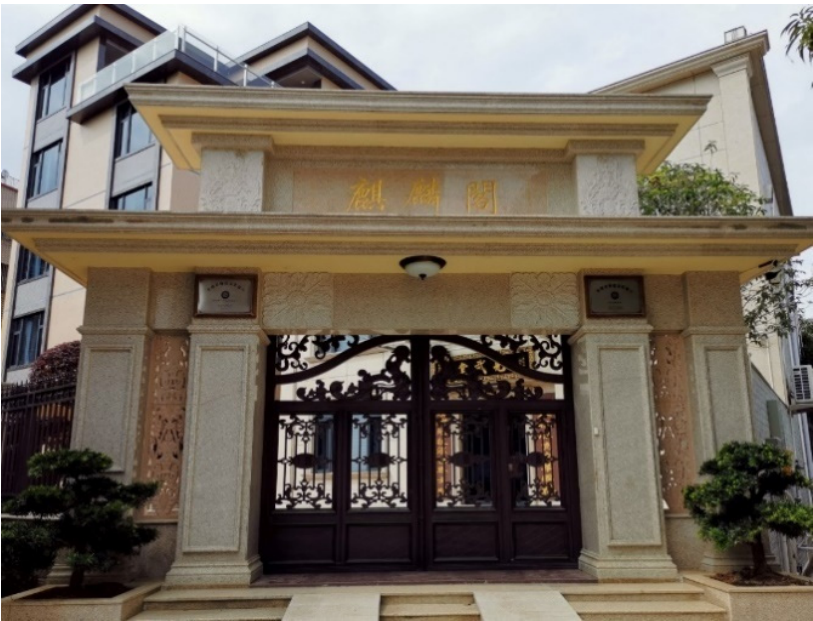
Figure A3. Cultural museum built by the community at the birthplace of ICH.